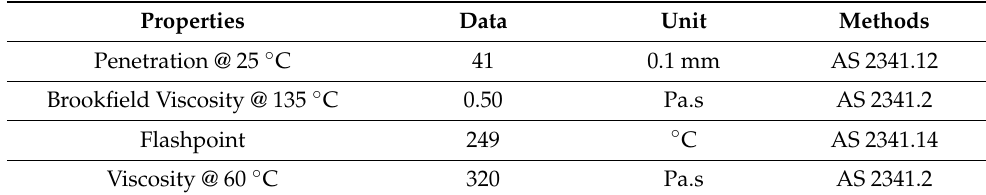
Table 1. Bitumen properties.